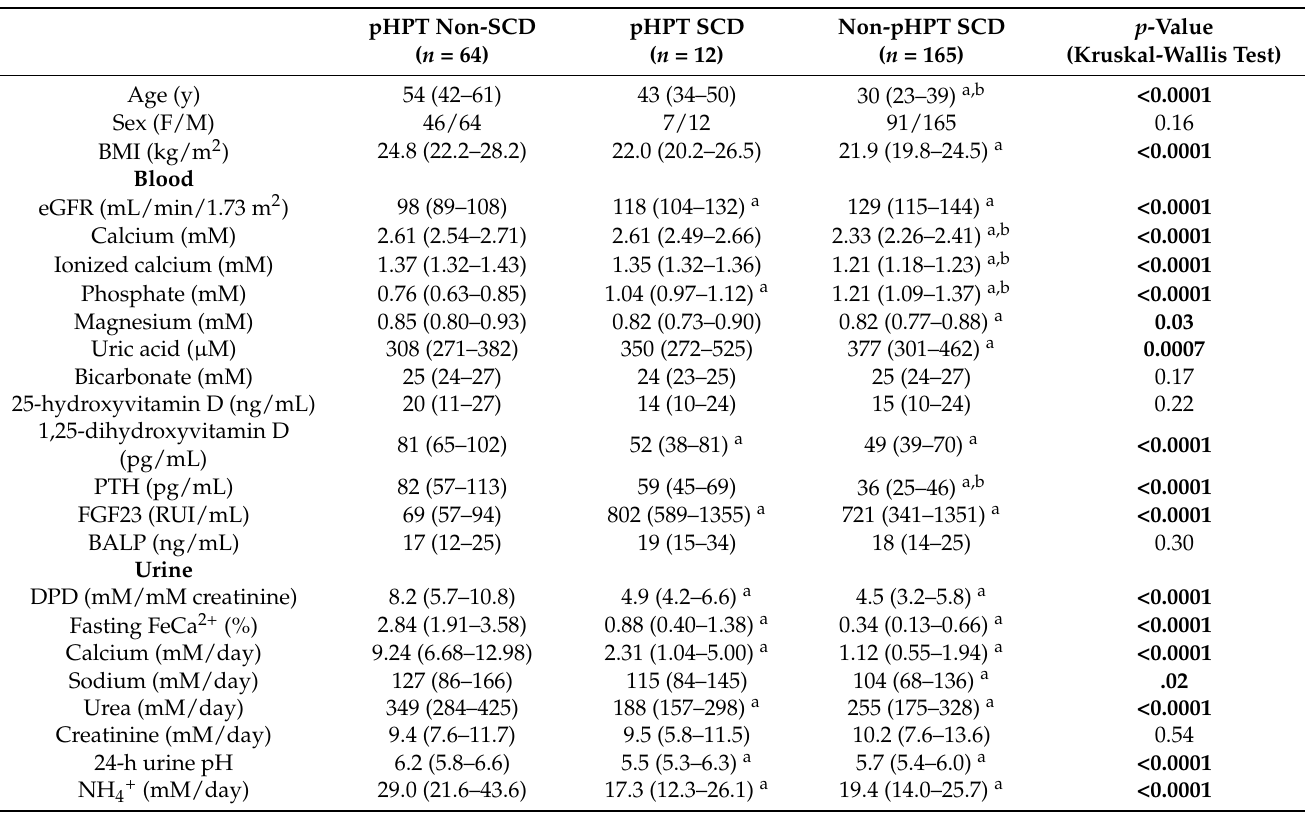
Table 1. Comparison of demographic and biological parameters between pHPT non-SCD, pHPT SCD and non-pHPT SCD